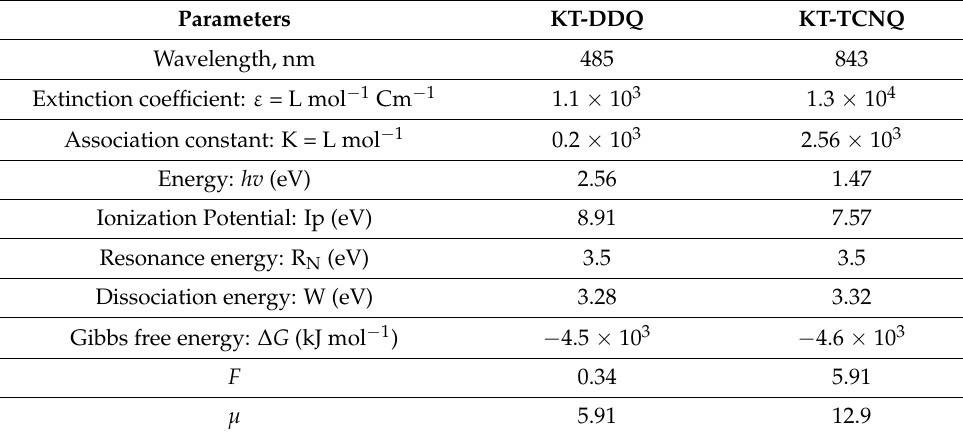
Table 2. Spectroscopic parameters for KT-DDQ and